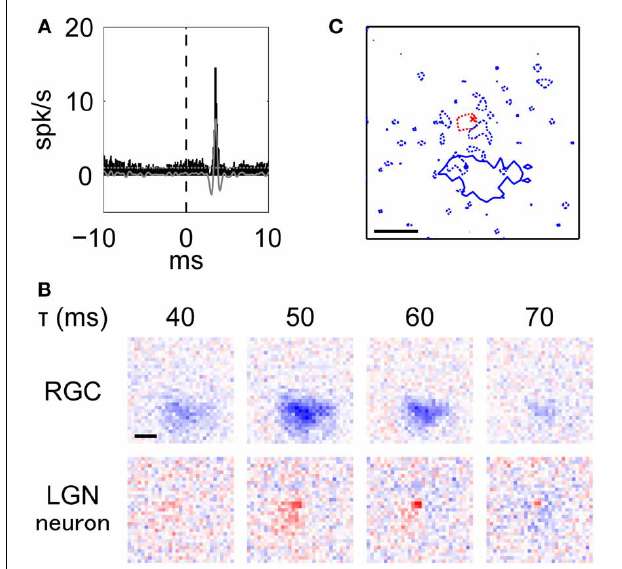
FIGURE 4 | Typical example of an RGN-LGN neuron pair with RFs of the opposite response sign. This was the pair shown in Figure 2C . (A)–(C) Details are the same as Figure 3 . Note that the blue dotted lines in (C) indicate the RF surround of the LGN neuron at 25% response level at latency